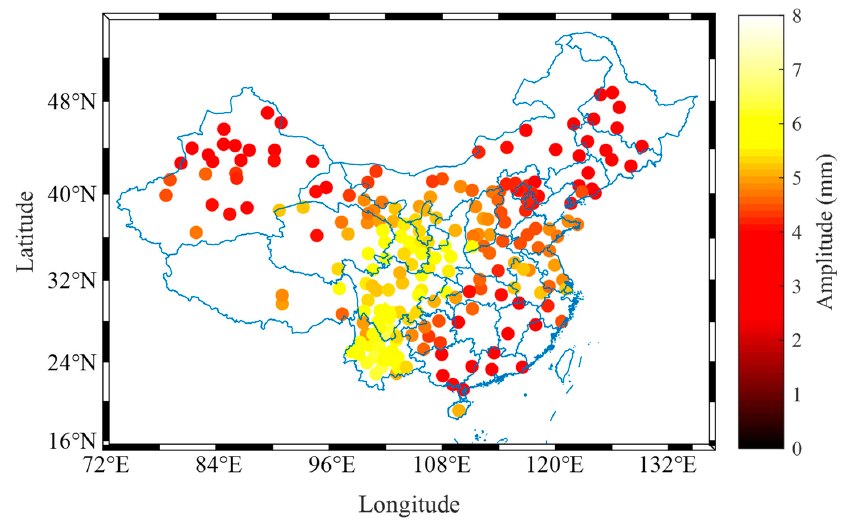
Figure 11. Semiannual PWV variation amplitudes (mm) at 377 GPS sites.